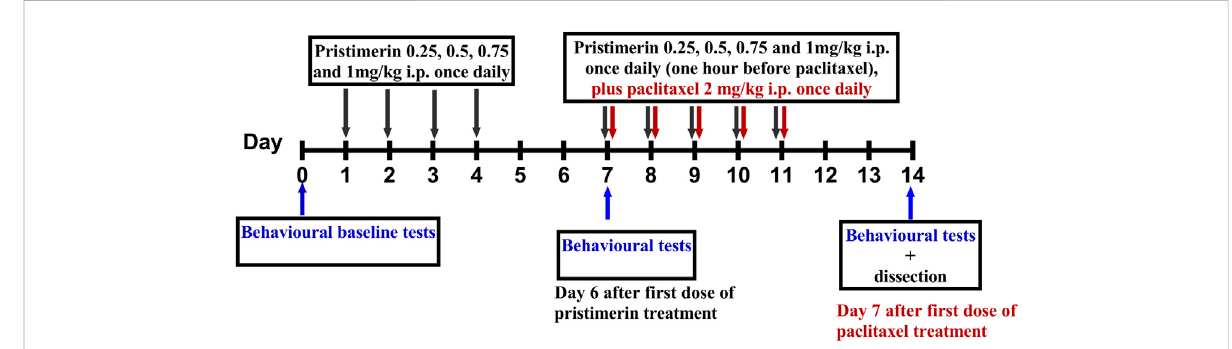
FIGURE 1 Drugadministrationschedulefortreatmentwithpristimerinagainstpaclitaxel-inducedallodynia.Theblackarrowsindicatethedayspristimerin was administered, the maroon arrows indicate the days when paclitaxel was administered, while the blue arrows indicate when the behavioral tests were